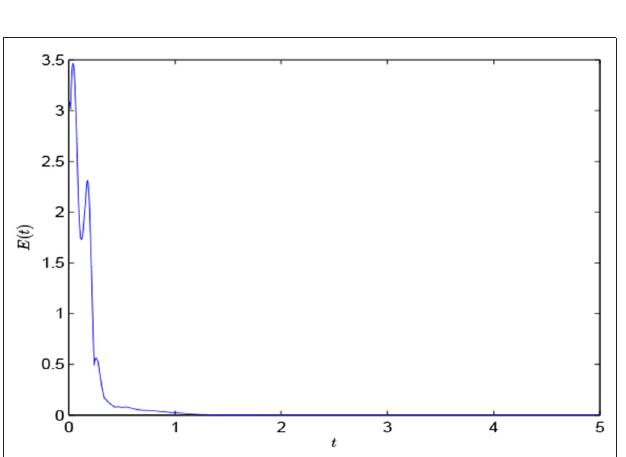
FIGURE 2 | The time evolution of the first component x i 1 in the i th oscillator, i = 1, ... ,10.